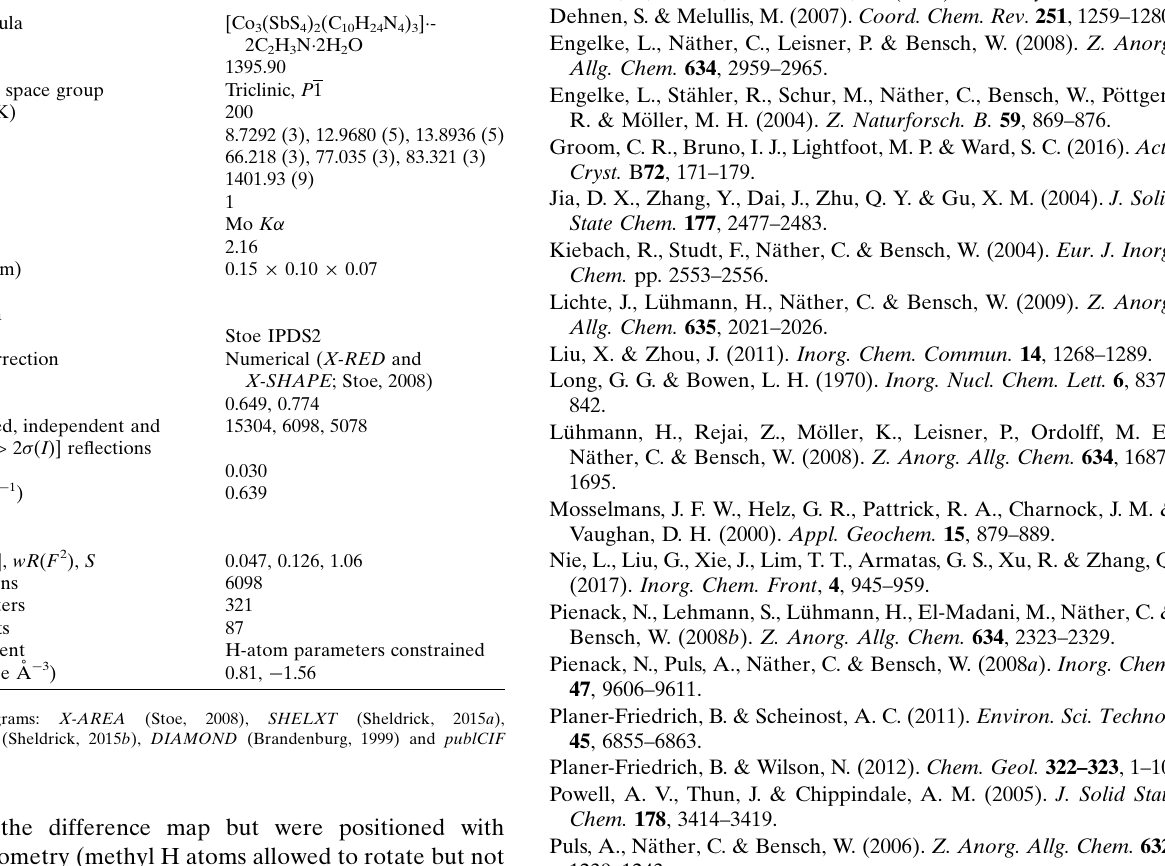
Table 3 Experimental details. Crystal data Chemical